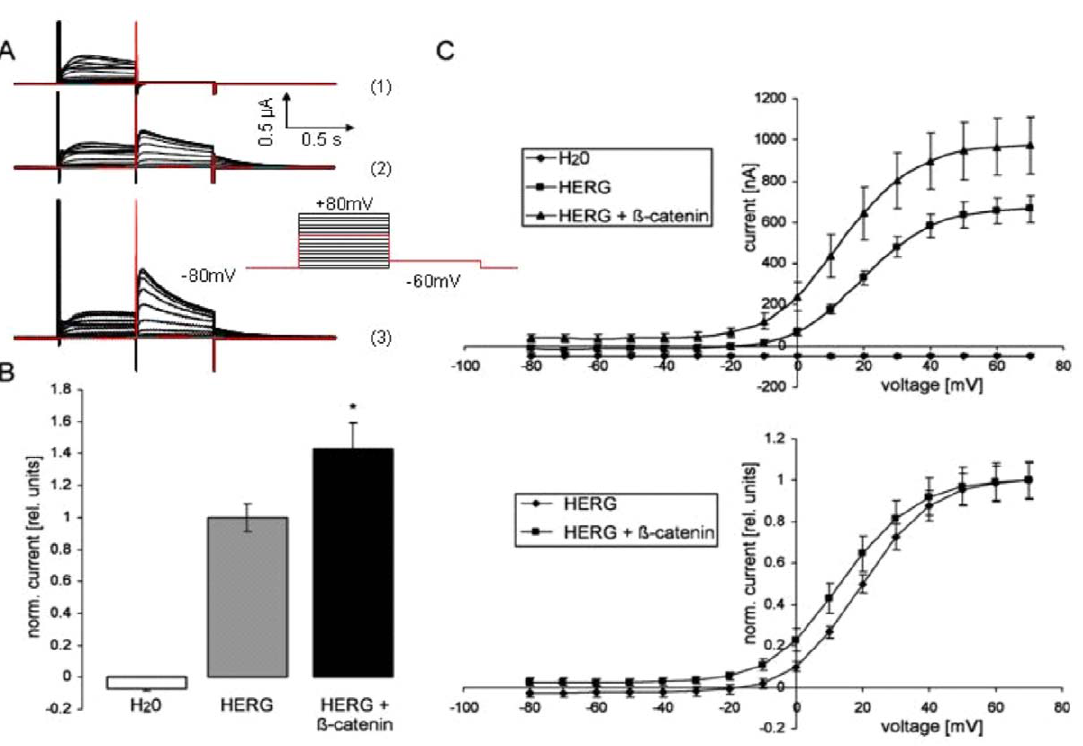
Figure 1. ß-catenin increases HERG current. A. Original tracings recorded in oocytes injected with H 2 0 (1), with cRNA encoding HERG (2) or HERG coexpressing ß-catenin (3). The oocytes were depolarized from 2 80 mV holding potential to different voltages followed by a 500 ms pulse to 2 60 mV evoking outward tail currents. The small insert displays the applied voltage protocol. B. Arithmetic means 6 SEM (n=8–11) of the normalized outward tail current following a depolarization to + 80 mV recorded in oocytes injected with H 2 0 (left bar), with cRNA encoding HERG (middle bar) or with RNA encoding HERG and ß-catenin (right bar). * indicates statistical significance (p , 0.05) from the absence of ß-catenin cRNA. C. IV curves of outward tail currents illustrated in B (upper panel) and IV curves of outward tail currents following normalization to the maximal tail current of the respective group (lower panel).